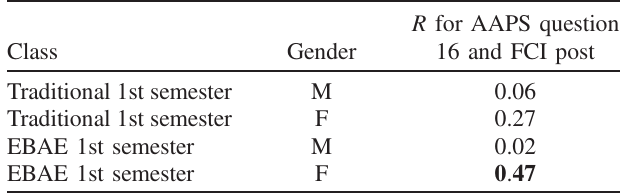
TABLE V. Correlation coefficients ( R ) for post-test scores for the AAPS survey question 16 (which asks whether students use physics principles or “ gut ” feeling when answering conceptual questions) and the FCI for different types of courses in first semester classes. R > 0 . 3 appears in